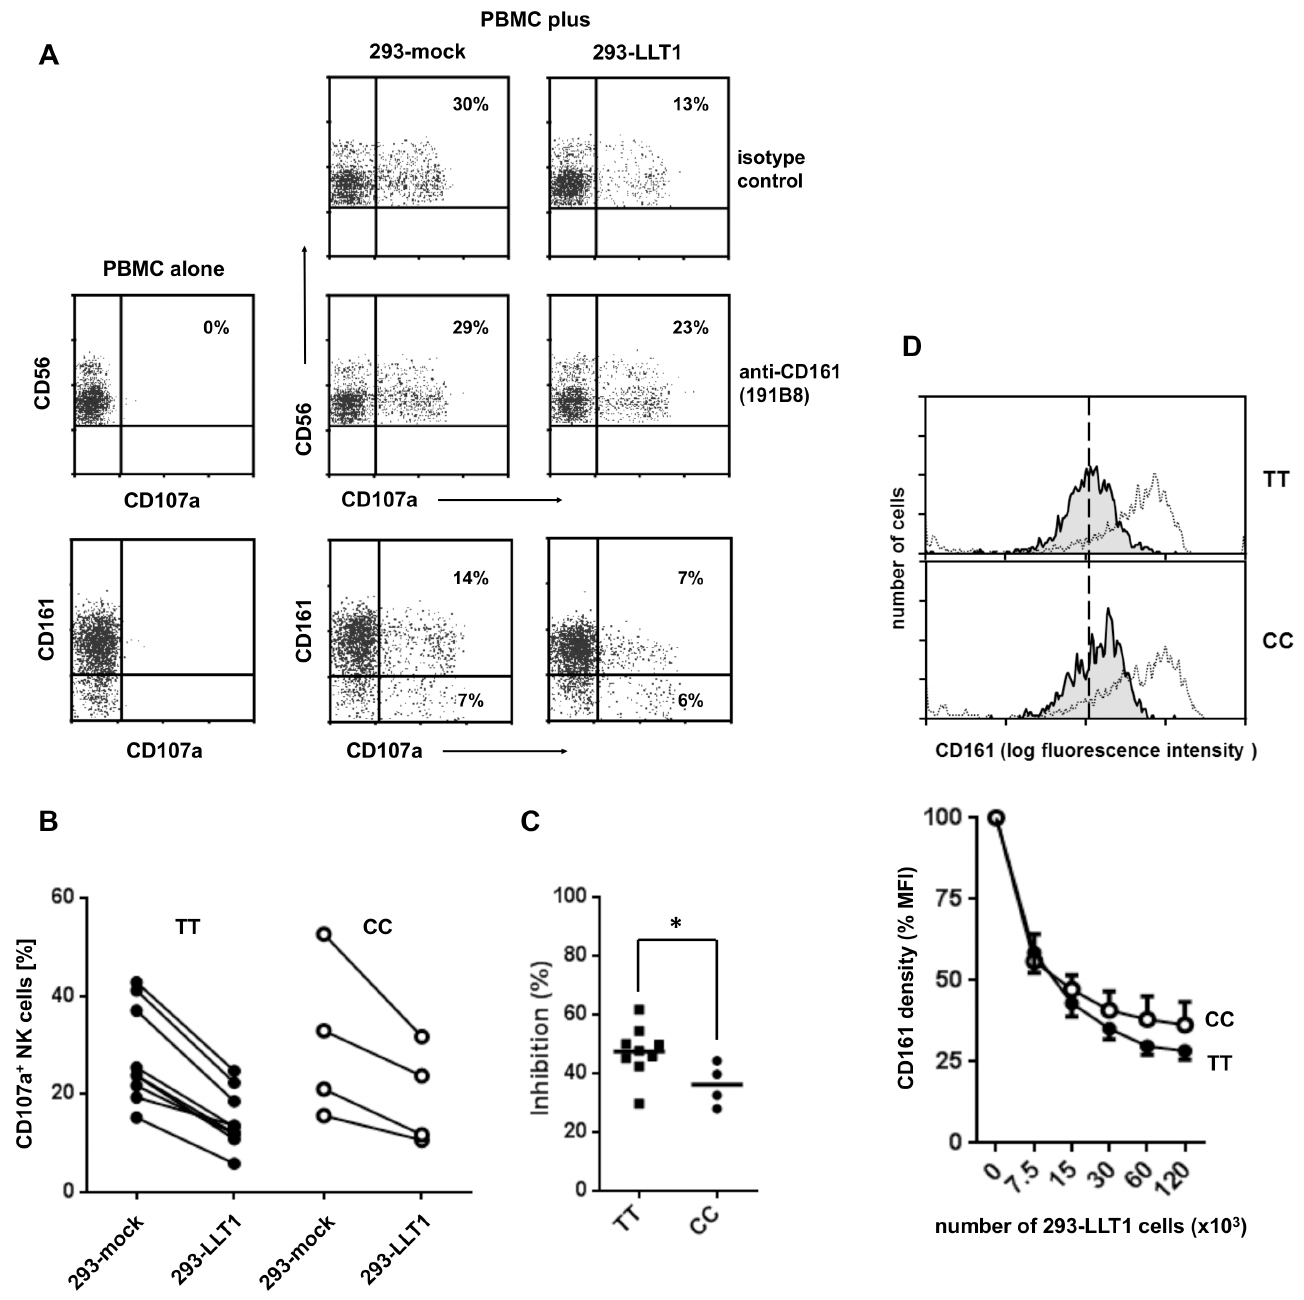
Fig 4. Inhibition of NK cell activation by LLT1-mediated triggering of CD161. PBMC were isolated and co-cultivated for three hours with 293-mock or 293-LLT1 transfectants. Activation of NK cells was assessed by monitoring CD107a expression on gated CD3 - CD56 + and CD3 - CD56 + CD161 + /CD161 - cells. (A) Abrogation of inhibition by antibody-mediated blocking of CD161/LLT1 interactions. Co-cultivation of PBMC with 293 transfectants was performed in the presence of the anti-CD161 mAb 191B8 or an isotype-matched control antibody. (B) Frequency of activated NK cells after cultivation with 293-mock or 293-LLT1 cells. PBMC from nine individuals with CD161 TT and four carriers of CC were studied. (C) Diminished capacity of CD161 from CC carriers to inhibit NK cell activation. % Inhibition was calculated as follows: 100 - [(%CD107a + NK cells in 293-LLT1 co-cultures / %CD107a + NK cells in 293-mock co- cultures) x 100]; * p < 0.05 (Mann-Whitney). (D) LLT1 induced CD161 down-regulation on IL-12 activated NK cells. PBMC were co-cultured for three hours with either mock transfected 293 cells or cells expressing LLT1. CD161 expression was monitored on gated CD3 - CD56 + NK cells. Depicted histograms show CD161 expression in untreated NK cells (open) and after treatment with 293-LLT1 transfectants (filled histograms). The broken vertical line indicates the peak of CD161 observed in LLT1-treated NK cells from a TT individual. The graph summarizes data obtained in experiments using cells from five TT and three CC individuals (mean ± SEM).